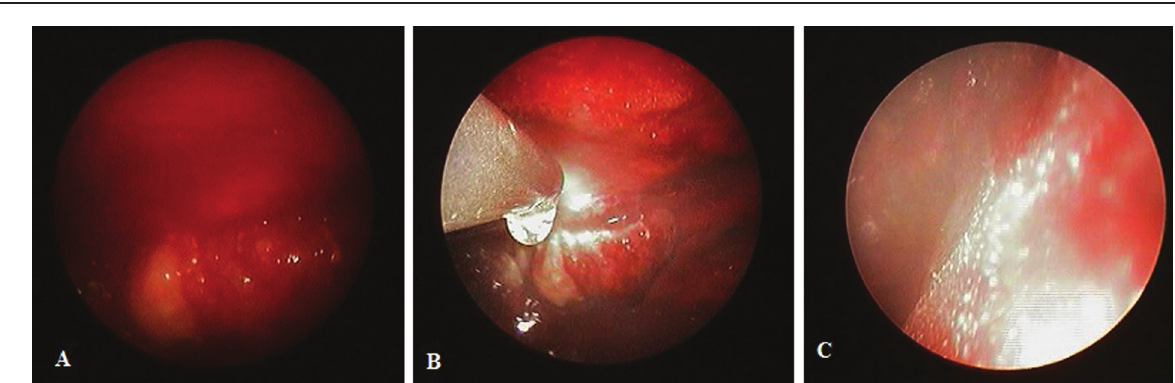
(a) Visible visceral pleural nodules with medical thoracoscopy. (b) Inserted thoracoscopic poudrage channel through thoracoscopic trocar with doxycycline spurt. (c) Spilled doxycycline on visceral pleural